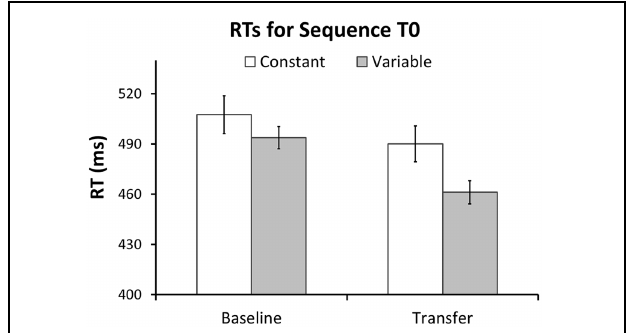
FIGURE 5 | Transfer effects on sequence T0 after constant and variable training. Mean response times at Baseline and Transfer for sequence T0 are shown separately for the each group. The Variable group showed a significantly larger RT reduction at Transfer than the Constant group. There were no significant group differences in RT at Baseline. Error bars represent standard error of the